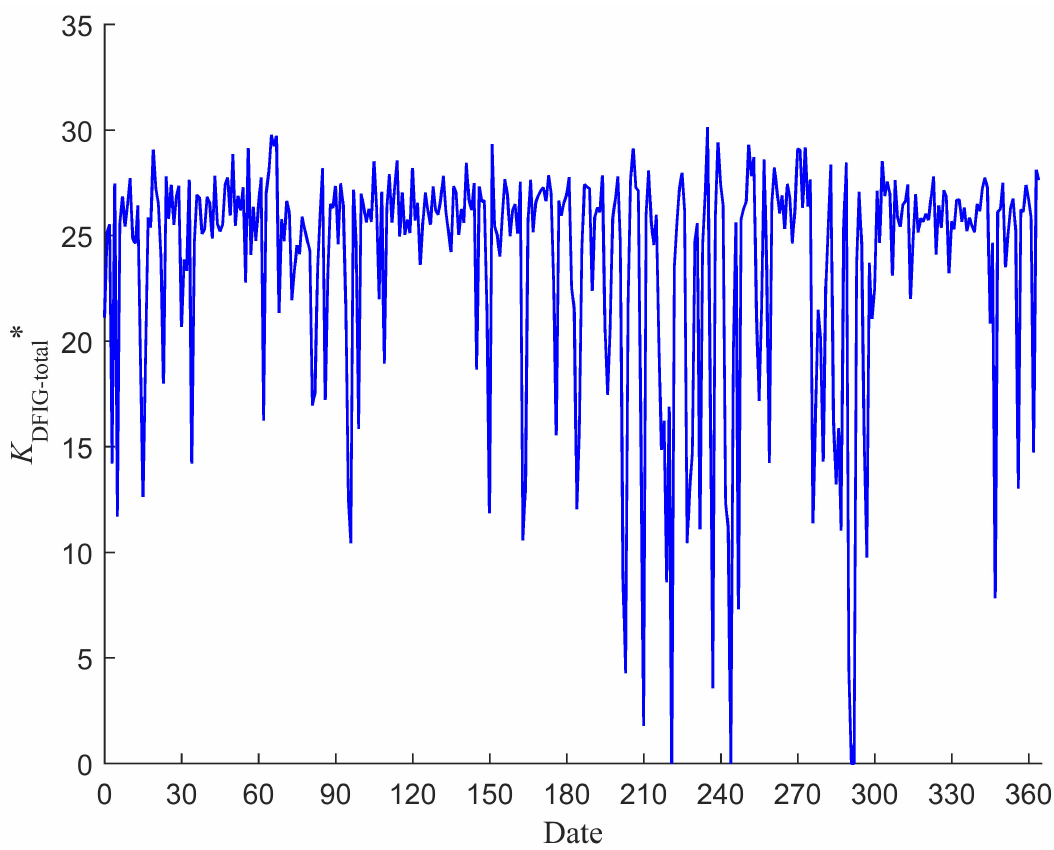
Figure 17. The K DFIG-total * for a year with an optimized droop coe ffi cient fluctuating slightly